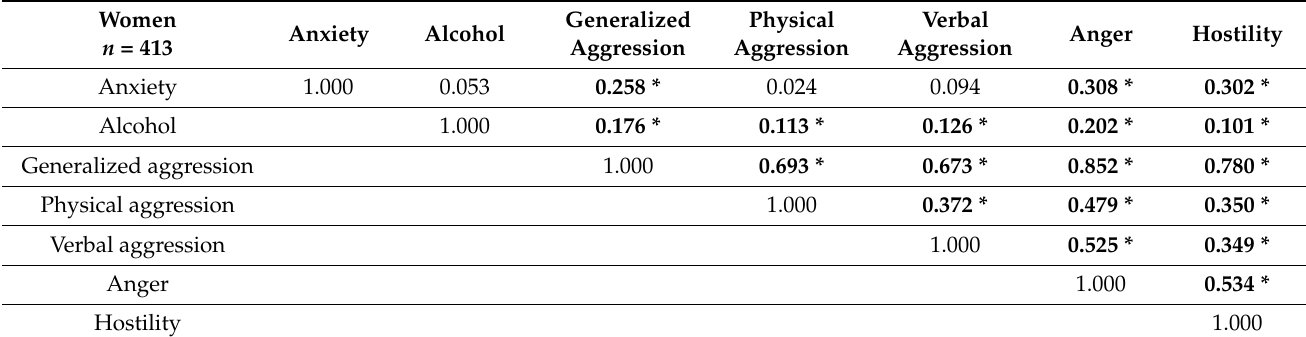
Table 4. Relationships between the severity of anxiety, the level of alcohol dependence and aggression in